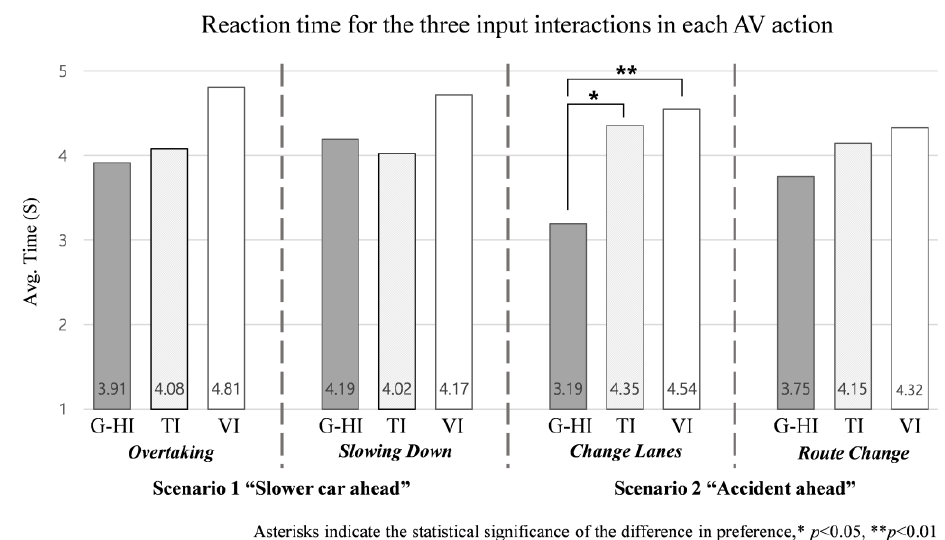
Figure 6. Reaction times for three input interactions considering each AV action in two driving scenarios.